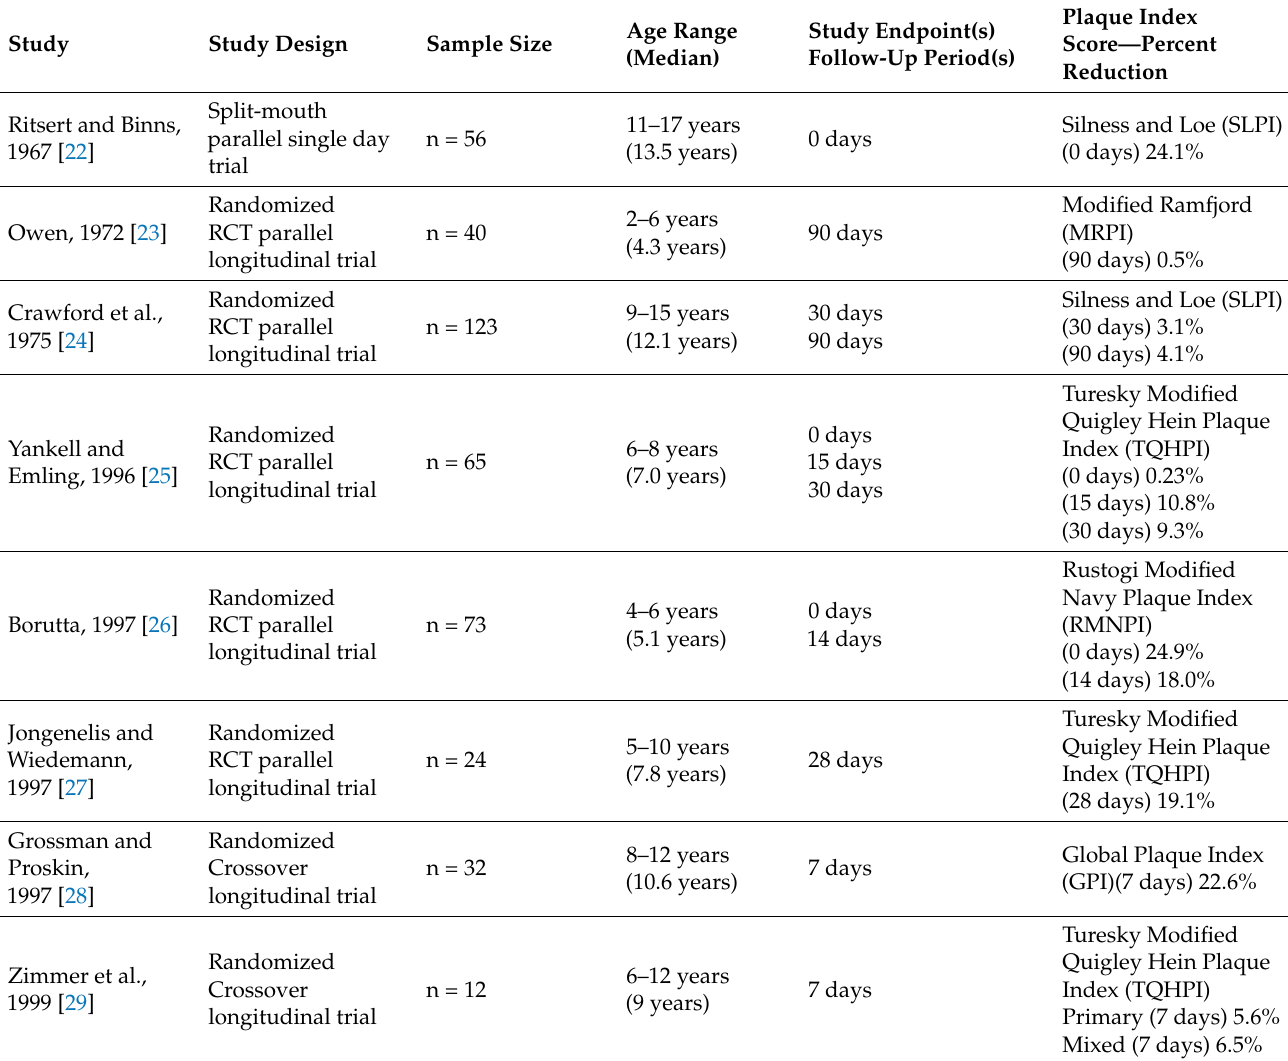
Table 1. Characteristics of pediatric, non-orthodontic inclusion